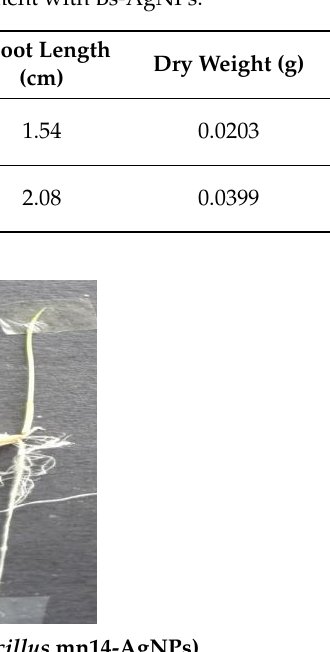
Table 7. Oryza sativa seed germination after treatment with Bs-AgNPs.